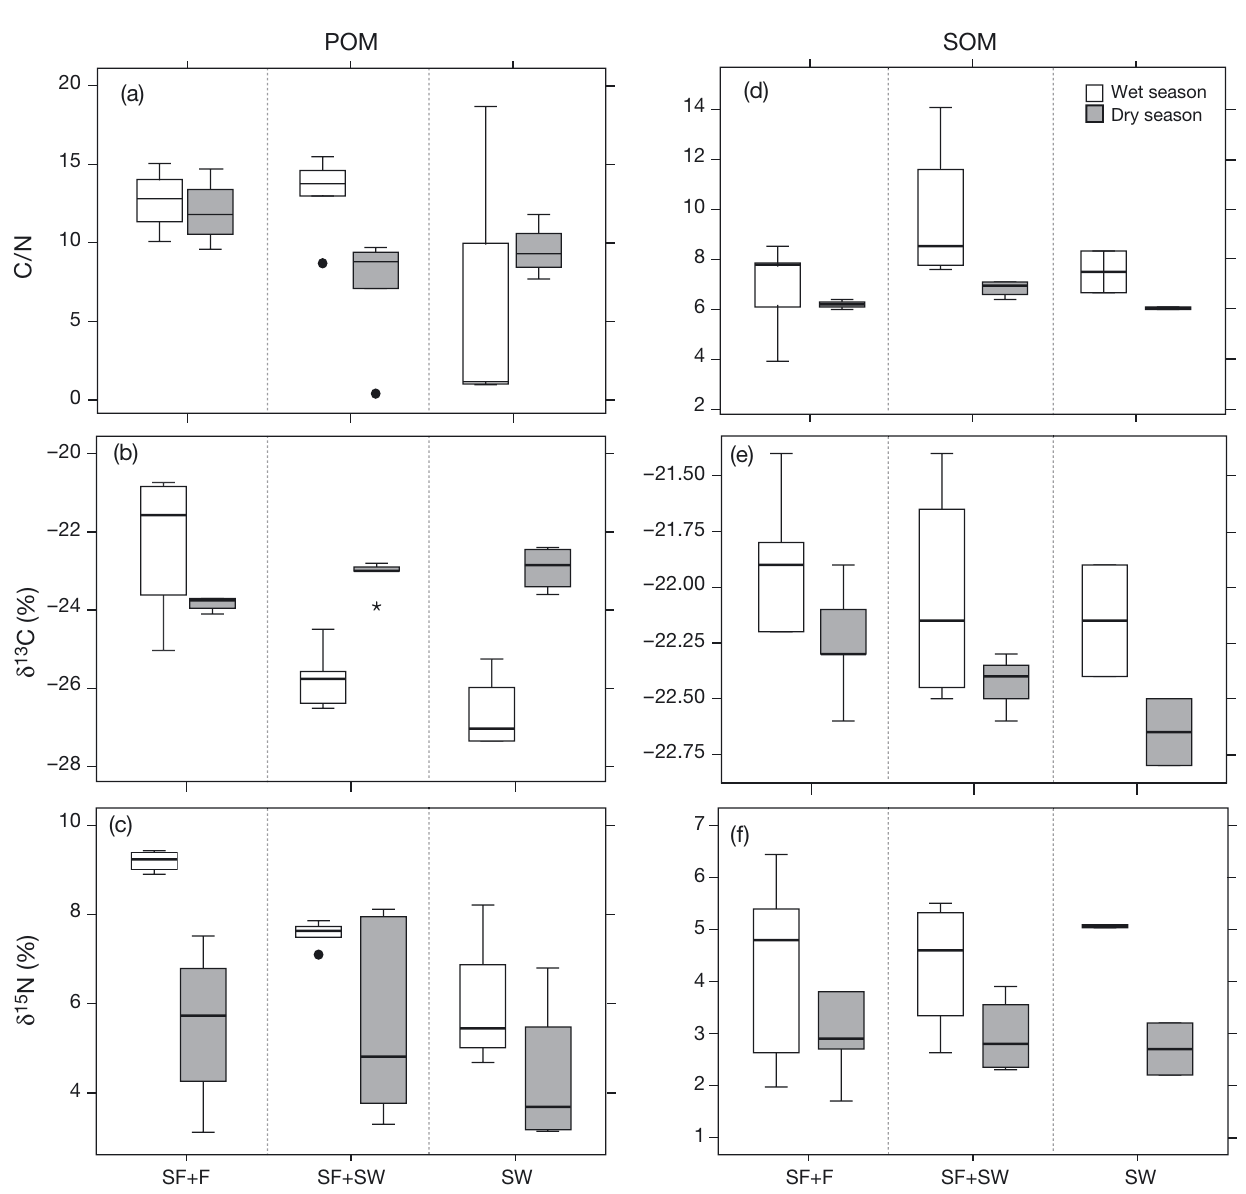
Fig. 5. Distribution of C/N, δ 13 C (‰) and δ 15 N (‰) of (a–c) particulate (POM) and (d–f) sediment organic matter (SOM) in the 3 culture areas (see Fig. 1) of Sanggou Bay during the wet and dry seasons. Box plots show the median value (line), 25 and 75% quantiles (box), 5 and 95% quantiles (whiskers), outliers (black dots) and extremes